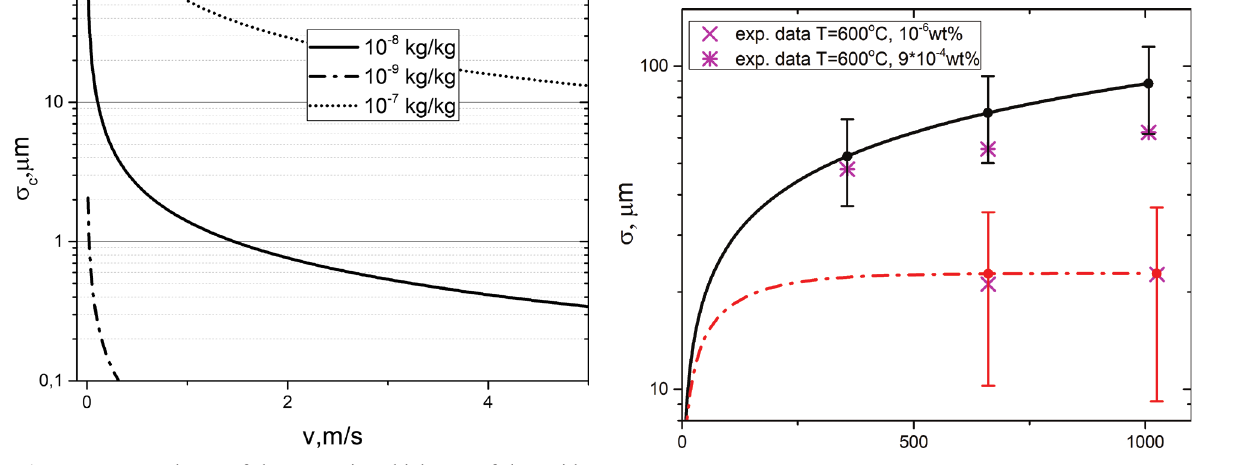
Figure 7. Dependence of the saturation thickness of the oxide film on the coolant velocity for various oxygen concentrations at T=550°C.